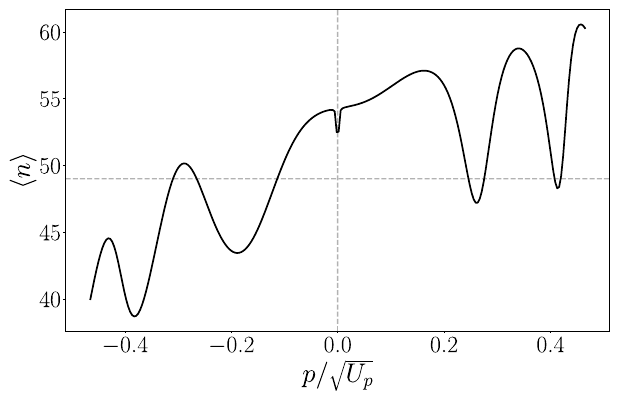
FIG. 7. The mean value of the photon number (75) of the fundamental mode at the end of the pulse. Here, we use α = 7 i to reproduce the form of the considered field. In order to avoid reaching the numerical limit of the machines used for the computation, we have multiplied the field constant by 0.2 (see Appendix G for details). We consider a field with a sinusoidal squared envelope with ω = 0.057 a.u., five cycles of duration, and field amplitude E 0 = 0.053 a.u.